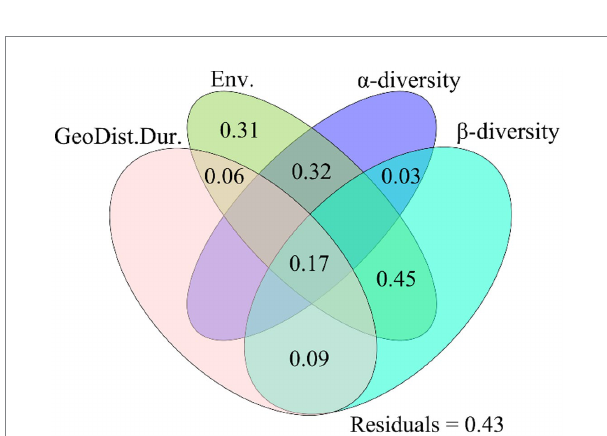
FIGURE 5 The excluded and interactive impacts of GeoDist.Dur., the dissimilarity of Env. and α -diversity, and β -diversity on the dissimilarity of plant community aboveground net primary production between C4313 versus W4513, C4313 versus W4693, and C4513 versus W4693. GeoDist.Dur.: geographic distance and warming duration; Env.: soil and air temperatures, soil moisture, vapor pressure deficit, available phosphorus, nitrate and ammonium nitrogen, and/or pH; C4313: non-warming plots at elevation 4,313 m; C4513: non- warming plots at elevation 4,513 m; W4513: warming plots at elevation 4,513 m; W4693: warming plots at elevation 4,693 m. Species and phylogenetic β -diversity data were obtained from Wang et al. (2021a,b), Frontiers in Ecology and